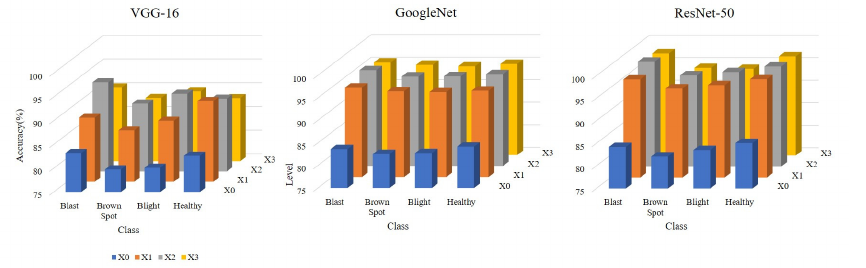
Figure 14. The effect of the level of data enhancement on the accuracy of neural network models.